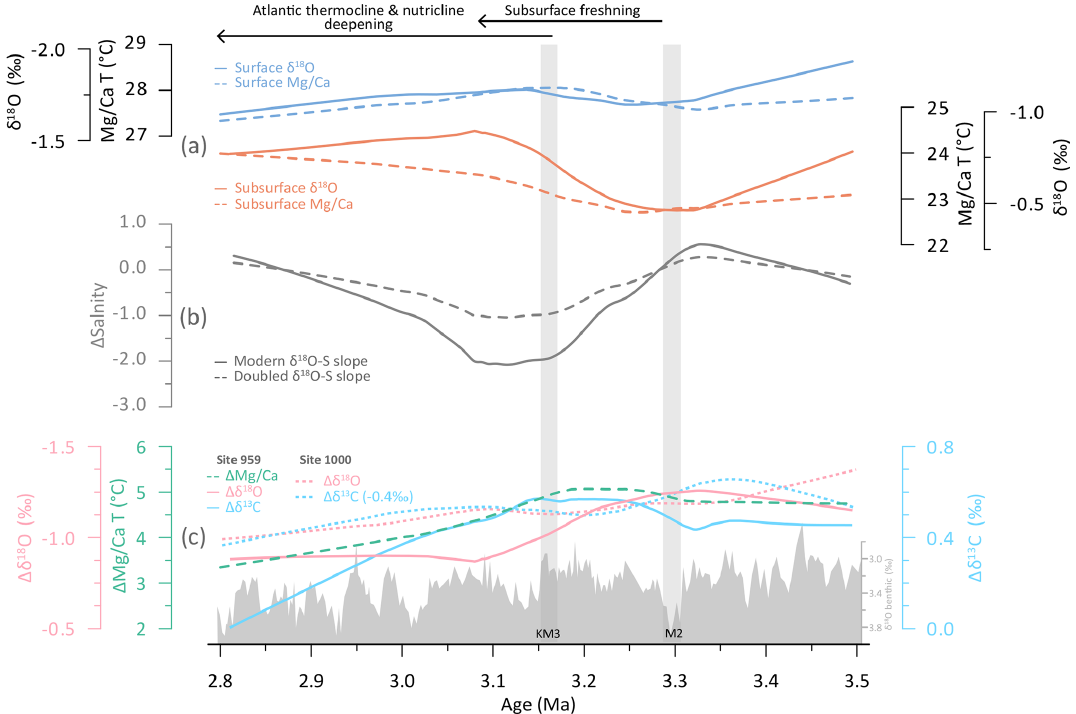
Figure 5. (a) Smoothed Mg / Ca and δ 18 O records from Site 959. (b) Relative magnitude of the salinity gradient between surface and subsurface, calculated by deconvolving (cid:49) surface–subsurface δ 18 O and Mg / Ca, and assuming a modern tropical Atlantic δ 18 O-S slope (0.11‰ per salinity unit; solid line) and a doubled slope (dashed line). (c) LOESS smoothed (span of 0.5 in PAST software, Hammer et al., 2001) thermocline and nutricline tracers from Site 959 (as in Fig. 4c) and Site 1000 in the Caribbean Sea (stippled lines, data from Steph, 2005). Site 1000 (cid:49)δ 13 C was steeper than at Site 959 and was corrected with − 0 . 4‰ to aid visual